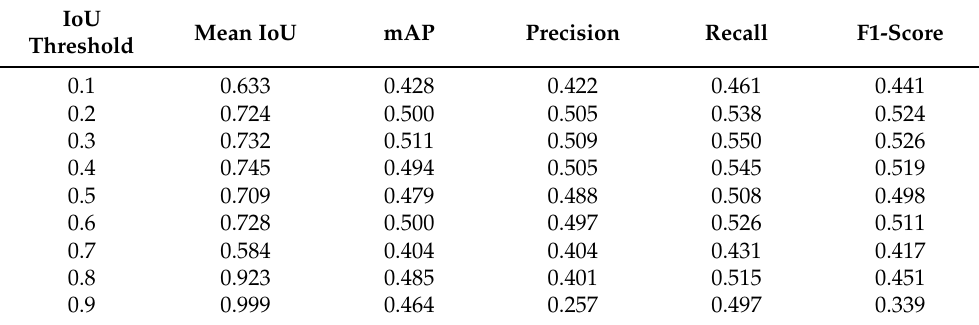
Table 1. The average detection indices (with 5-fold cross validation) of SEM-RCNN based on different IoU threshold settings.